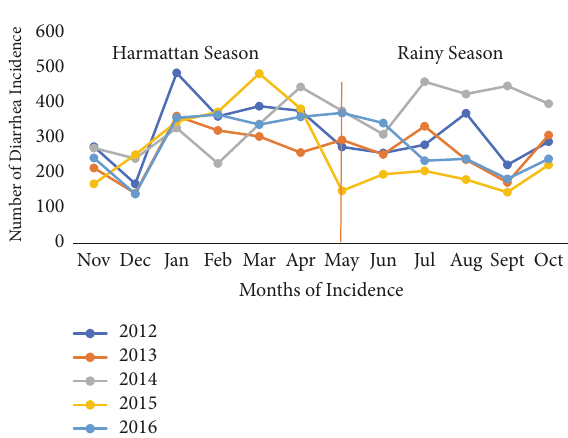
Figure 7: Yearly seasonal trend of diarrhea incidence in Jasikan District